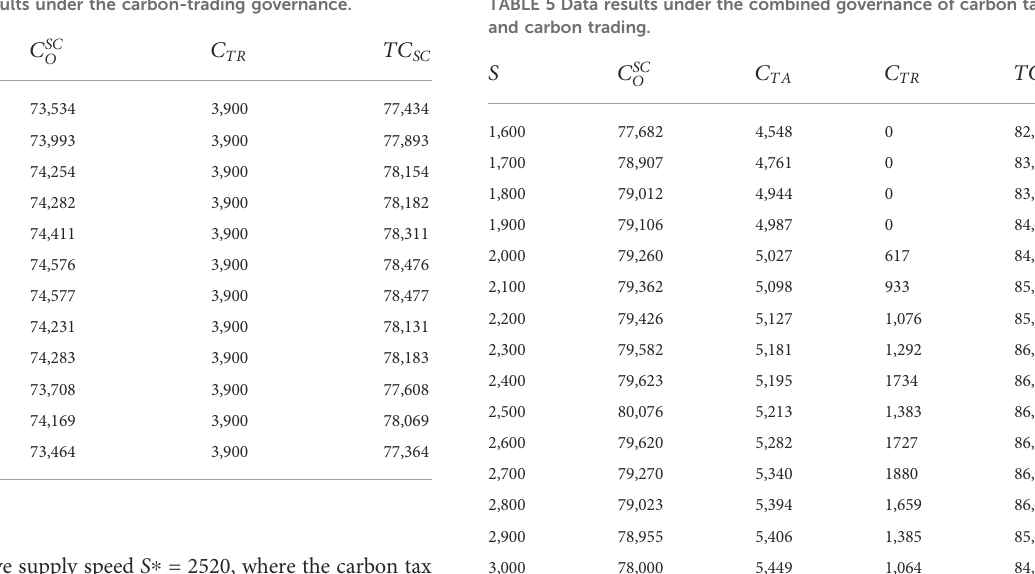
TABLE 4 Data results under the carbon-trading governance. TABLE 5 Data results under the combined governance of carbon tax